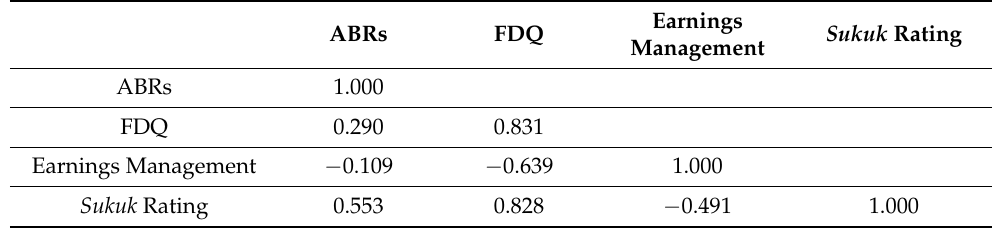
Table 5. Discriminant Validity—Fornell and